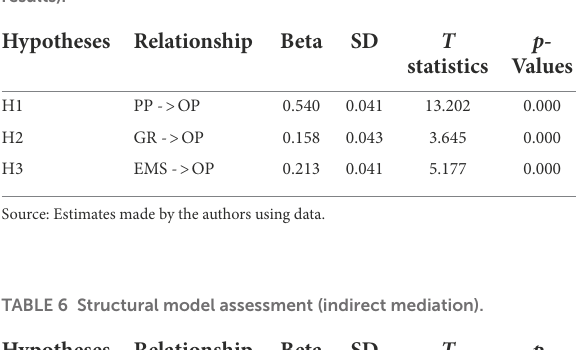
TABLE 7 Structural model assessment (moderation effects).